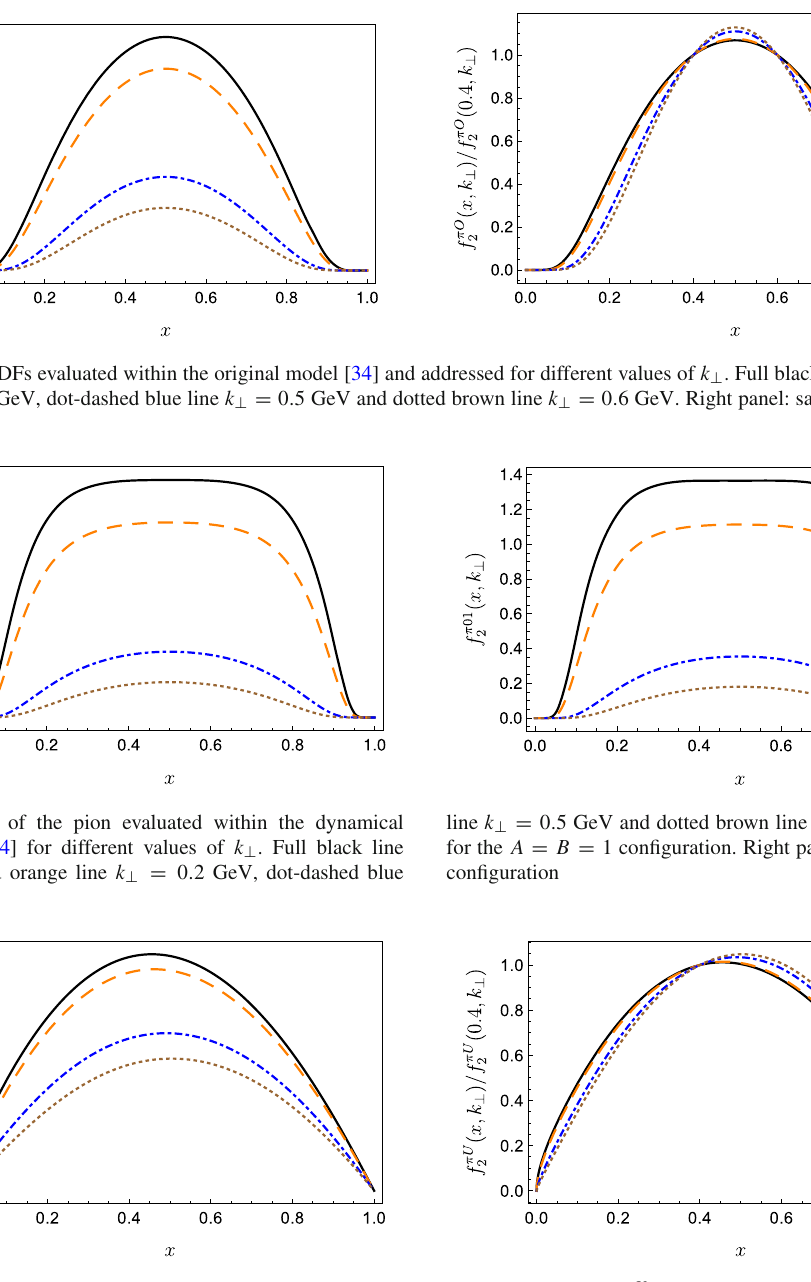
Fig. 4 Same of Fig. 2 but for the universal model of Ref. [36]. In the left panel, the quantity x f π U